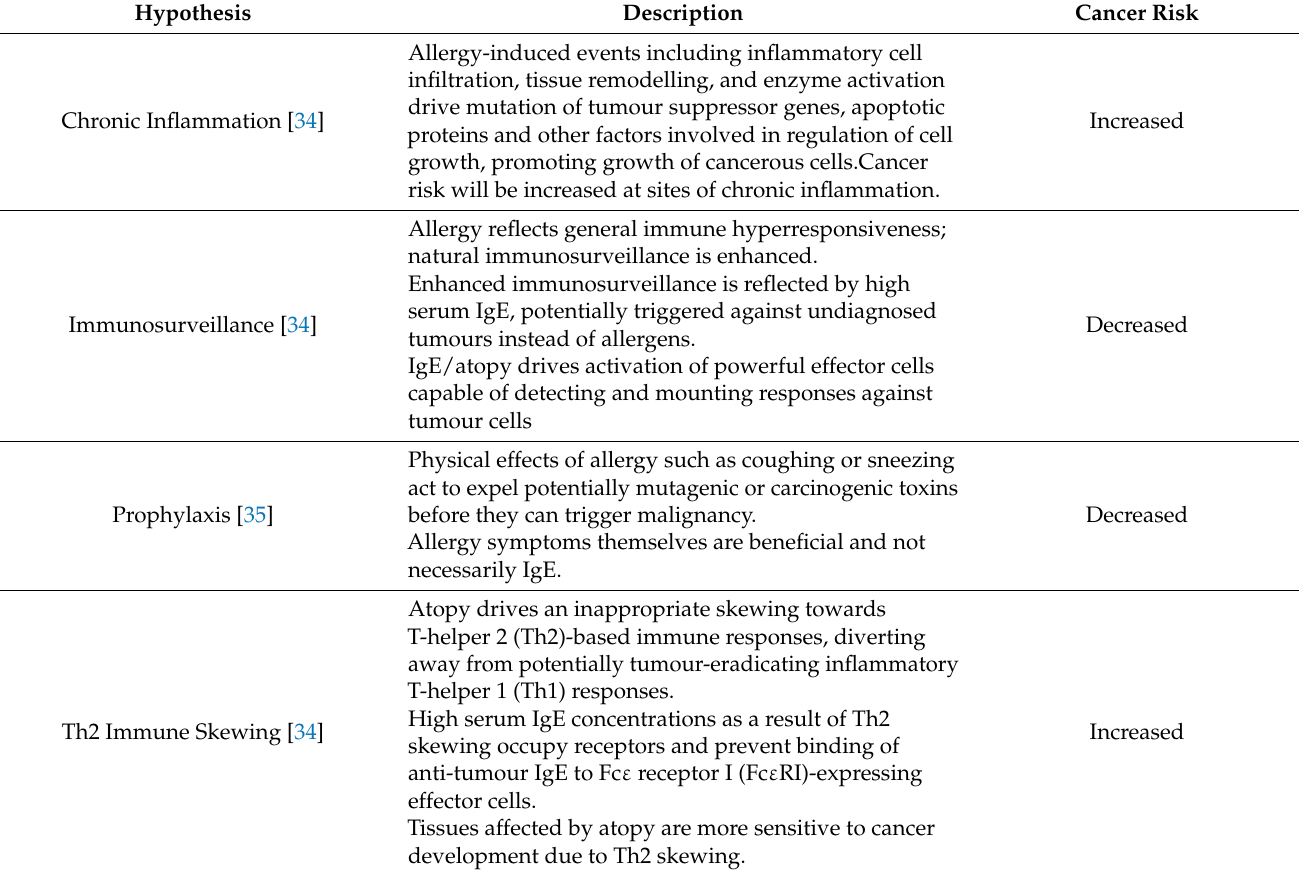
Table 1. Proposed hypotheses explaining relationships between allergy, IgE, and